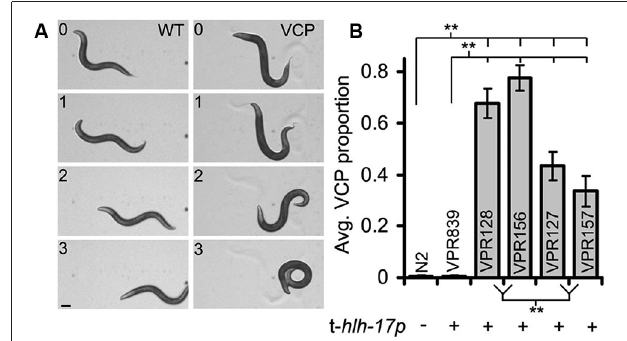
FIGURE 4 | A subset of C. elegans strains carrying transgenic arrays containing the trans- hlh-17 promoter (t- hlh-17p ) to drive expression of reporters in the CEPsh glial cells display a ventral coiler phenotype (VCP) during backward movement. (A) A time-lapse montage of worms showing a normal/sinusoidal pattern during backwards locomotion (WT, left column). Worms with many copies of the t- hlh-17p coil when they attempt to crawl in reverse (VCP, right column; strain VPR156). Numbers indicate time in seconds. Scale bar, 100 µ m. (B) Non-transgenic worms (WT, N2) do not display the VCP, but different strains of worms (VPR) containing the t- hlh-17p , except the VPR839 strain, display varying degrees of abnormal locomotion. ** Indicates a significant difference. Adapted from Stout et al.